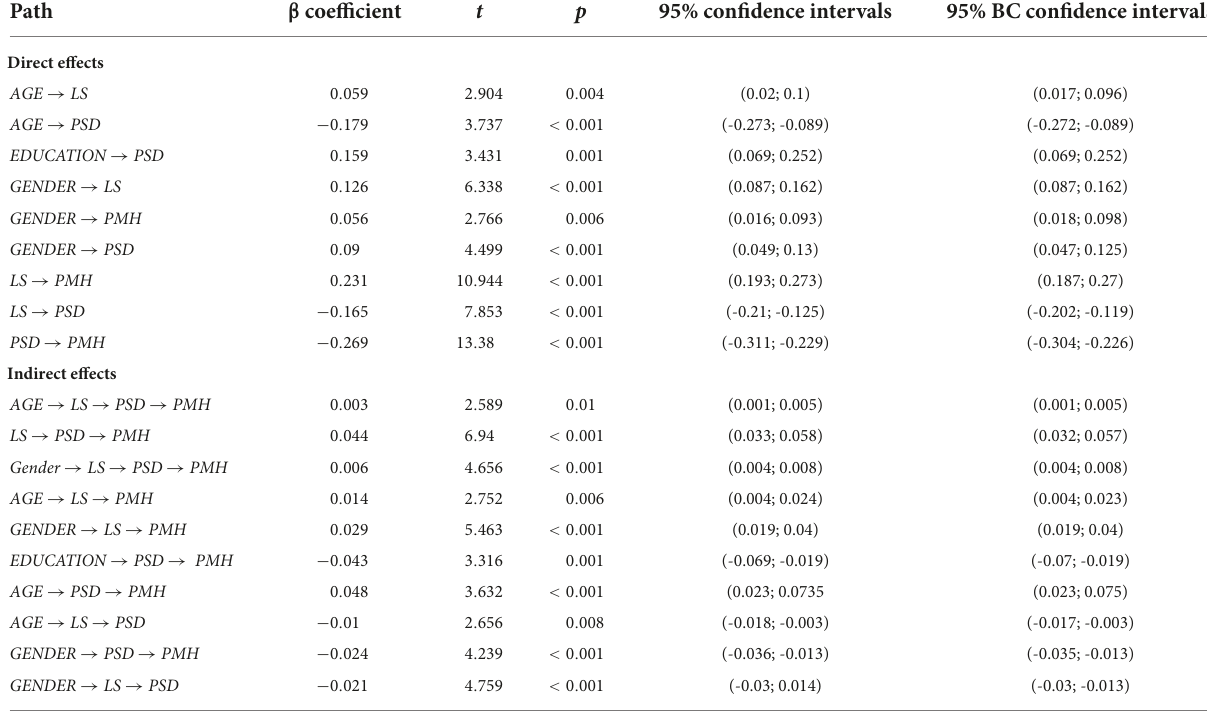
TABLE 5 Results of structural model: Direct effects and indirect effects. Path β coefficient t p 95% confidence intervals 95% BC confidence